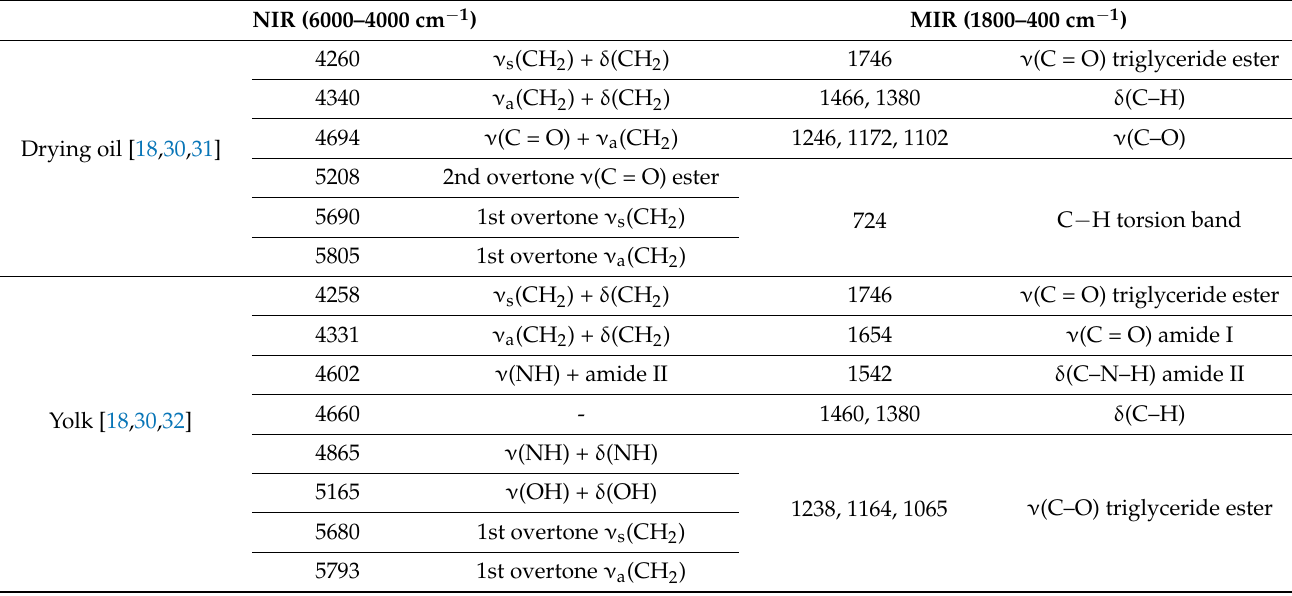
Figure 2. NIR (left) and MIR (right) spectra of: ( a ) linseed oil; ( b ) model painting sample of linseed oil on tempera; ( c ) model painting sample of tempera grassa ; ( d ) model painting sample of tempera; ( e ) egg yolk; ( f ) model painting sample of tempera grassa with dammar varnish; ( g ) dammar resin. All model samples contained lead white as a pigment. All spectra of the reference materials and model painting samples were acquired in reflection mode, with the exception of the spectrum of dammar which was acquired in transmission mode. The dashed lines indicate the two bands at 1740 and 1650 cm − 1 , respectively characteristic of oil and yolk in the MIR region. Table 2. Assignments of the main bands observed in the NIR and MIR spectra of the components of the mock-up samples.